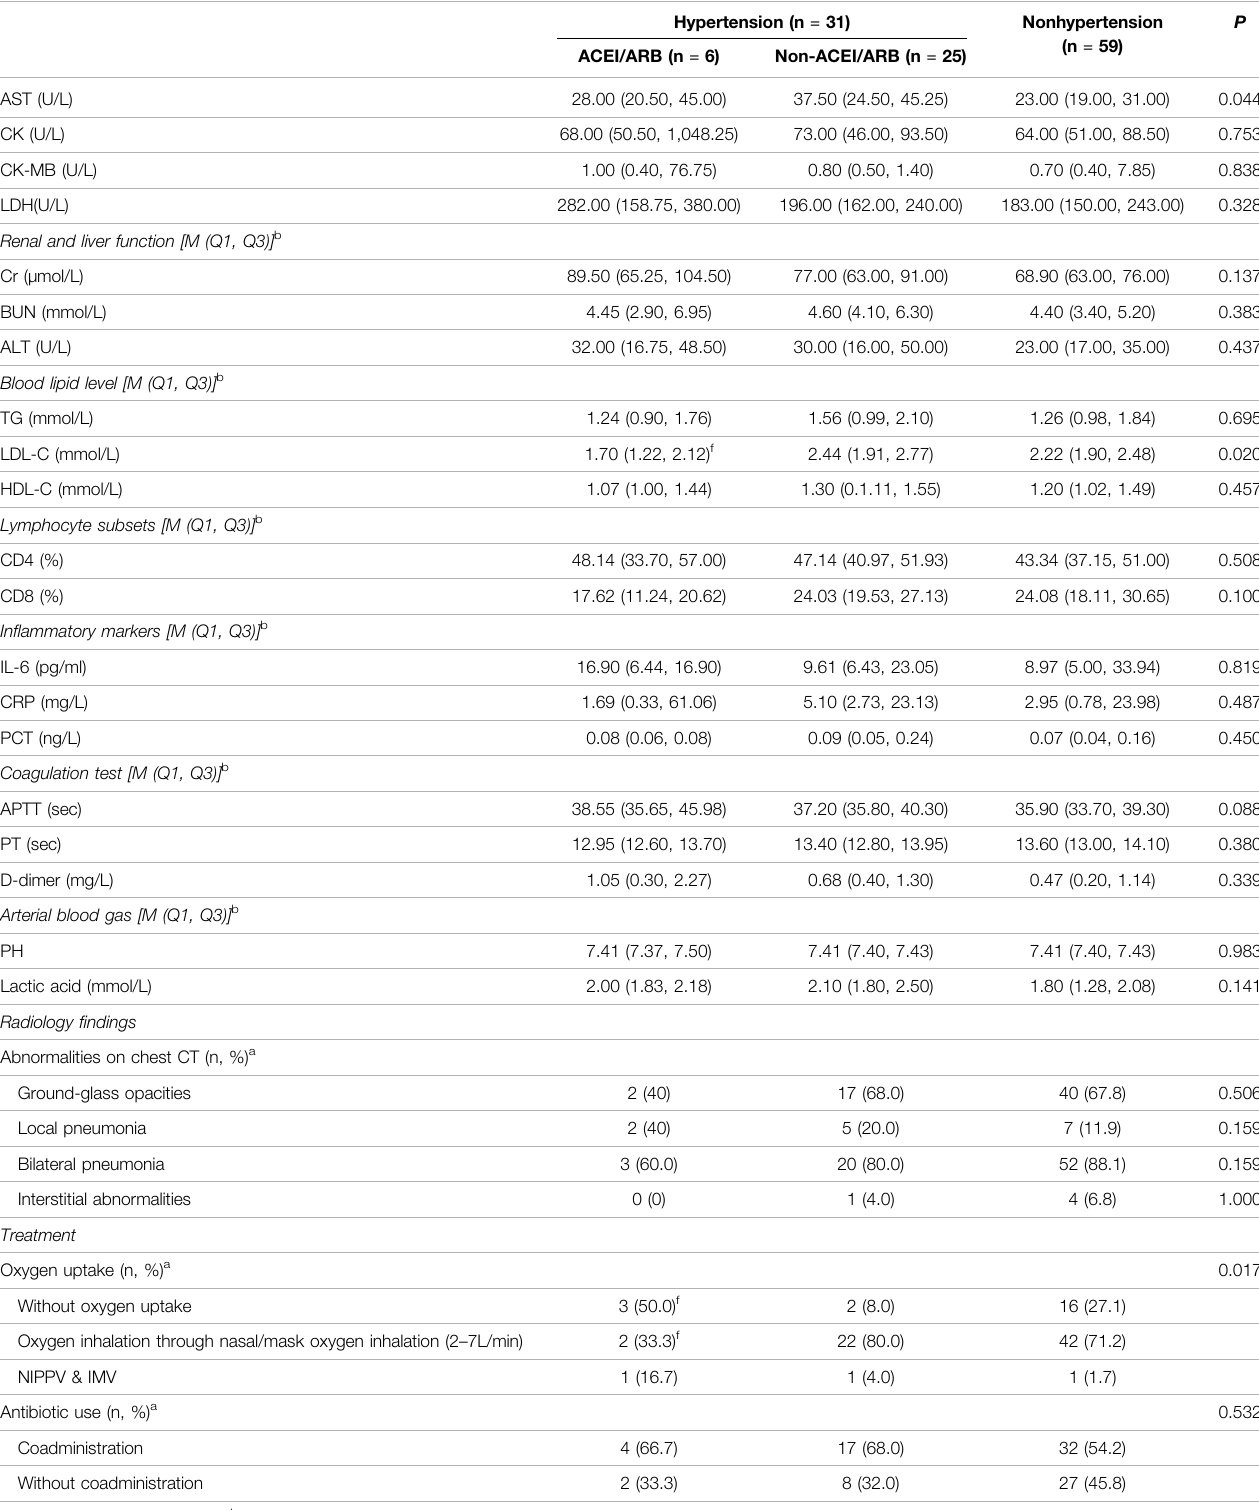
TABLE 2 | ( Continued ) The comparison of demographic and clinical characteristics, laboratory and radiology fi ndings, clinical measures, clinical outcomes, and severity of COVID-19 among ACEI/ARB, non-ACEI/ARB, and nonhypertension